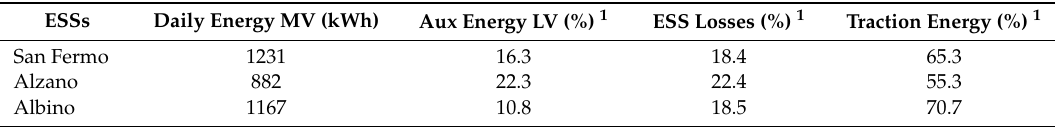
Table 3. Daily energy flows for three ESSs.